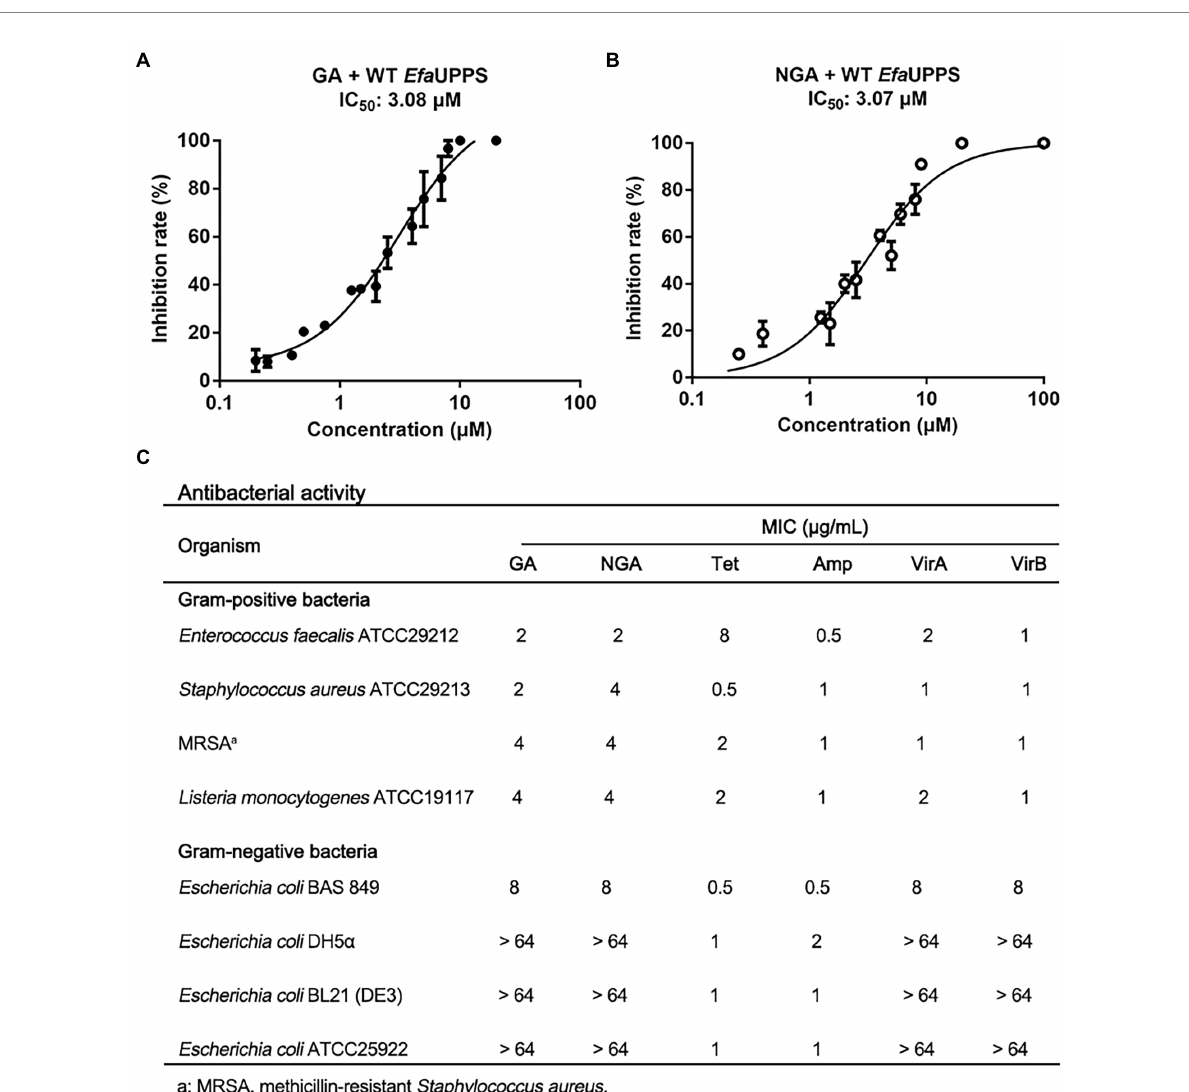
FIGURE 2 GA and NGA are strong inhibitors of Efa UPPS. (A,B) In vitro inhibitory activities of GA (A) and NGA (B) toward Efa UPPS. The calculated fluorescence percentages were plotted versus antibiotic concentrations on a semi-log scale (mean value ± SEM of three biological replicates). (C) Minimum inhibitory concentrations (MICs) of GA and NGA. Tetracycline (Tet), ampicillin (Amp) and viridicatumtoxins (VirA and VirB) were used as the positive controls. The data are presented as mean values from three independent biological replicates ( n = 3, SD =